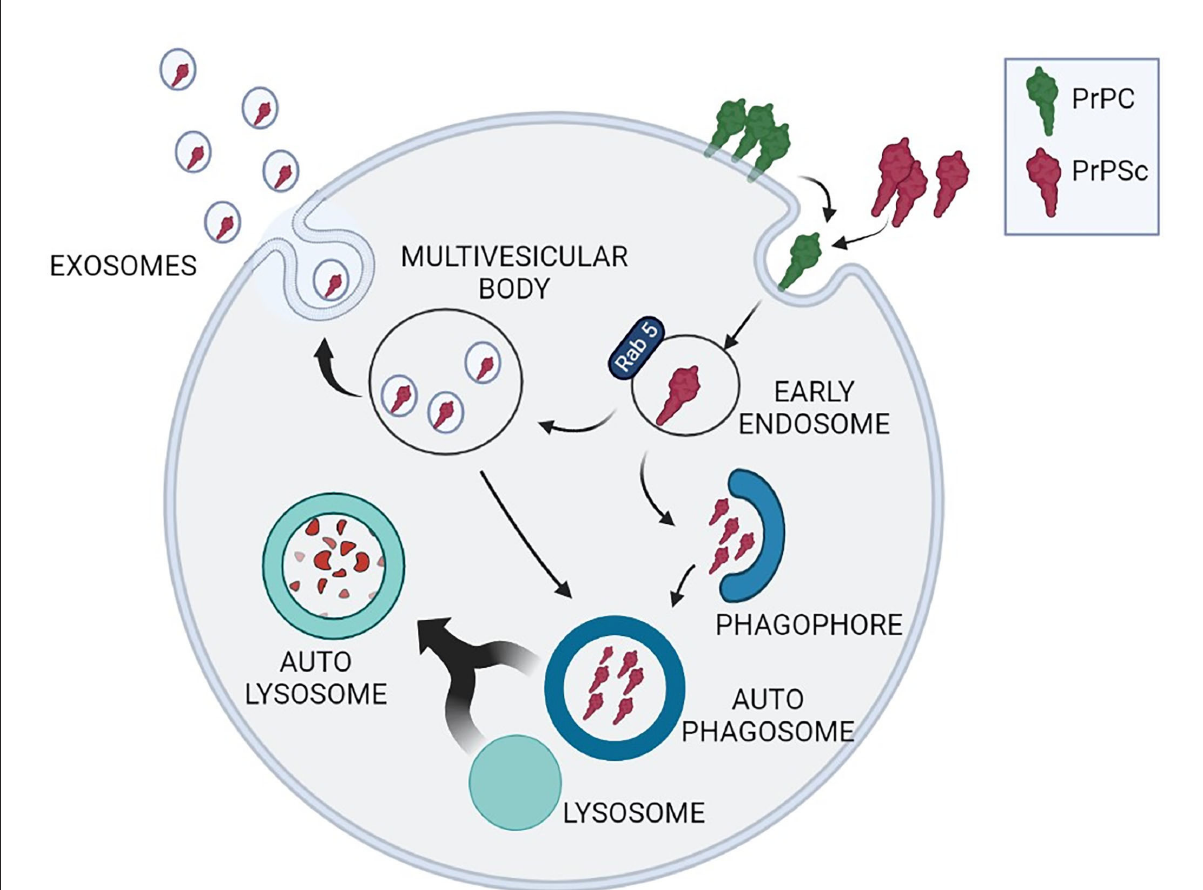
FIGURE1 Schematic representation of the interplay between exosome release and autophagy to reduce the intracellular burden of PrP Sc . PrP C (green) conversion into neurotoxic PrP Sc isoform (red) occurs during PrP C recycling through a stochastic event or after interaction with exogenous PrP Sc . Neuronal strategies to remove cytoplasmic PrP Sc comprehend protein degradation through macroautophagy or PrP Sc insertion into exosomes contained in multivesicular bodies (MVBs). MVBs can either release exosomes containing PrP Sc , or reenter the autophagy